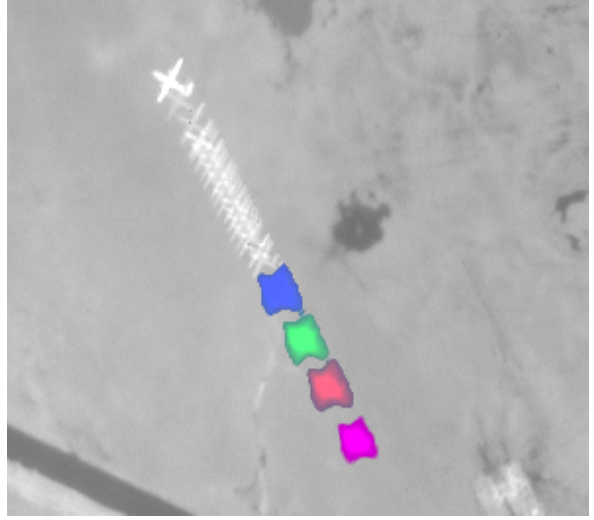
Figure 2: Effect of image fusion on a moving object. The pur- ple/near infra-red, red, green and blue blobs show the plane as imaged by a handful of multi spectral frames, and the approxi- mately 18 gray planes illustrate how many panchromatic images were fused.